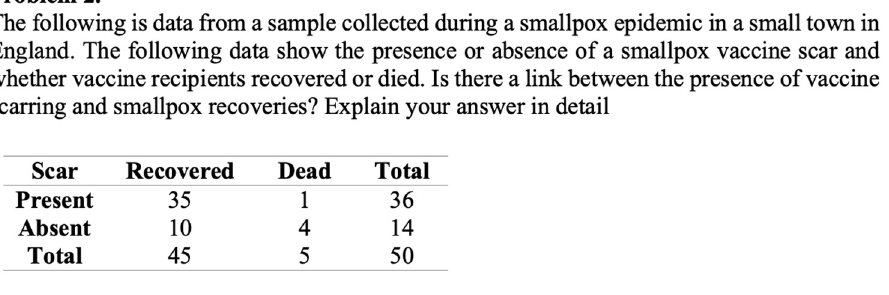
Figure A4. Activity/Problem 2 (Retrieved from [37]).